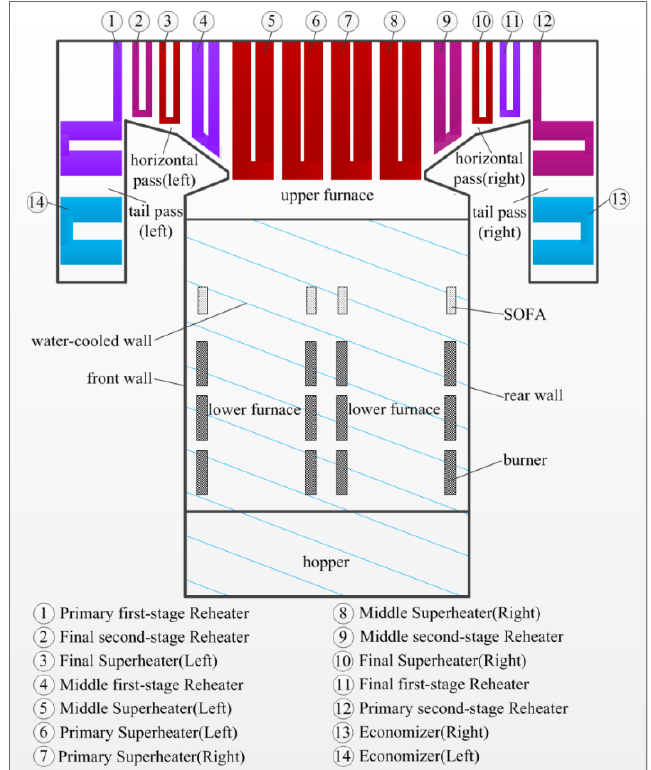
Figure 7. Schematic of the T-type double-reheat boiler.